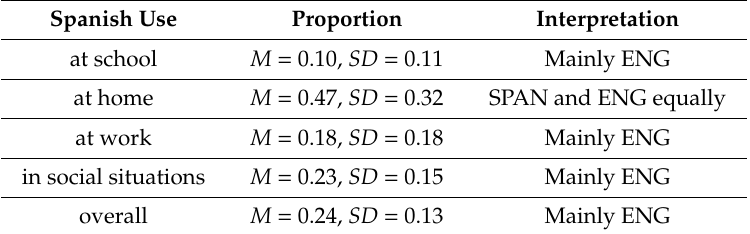
Table 2. Test group proportion Spanish language